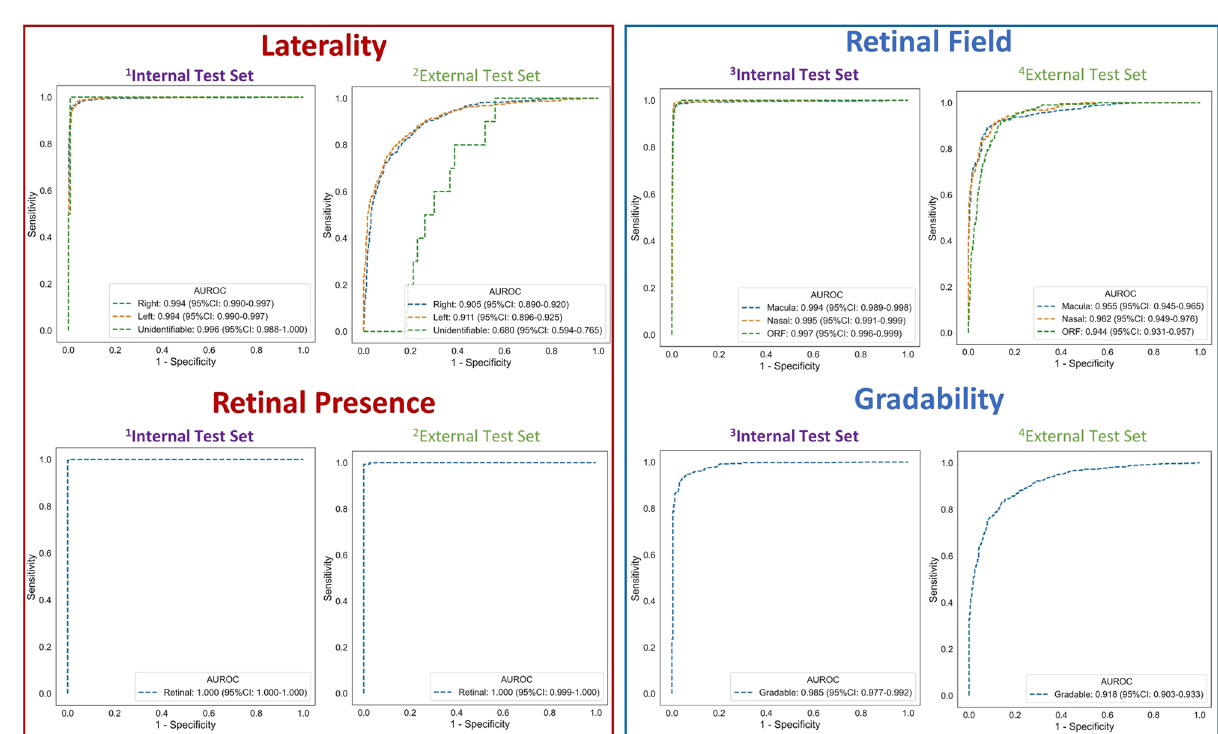
Figure 4. Multi-output model receiver operating characteristic curves. 1 Test set size = 1541 images, 2 Test set size = 1479 images, 3 Test set size = 1466 images, 4 Test set size = 1427 images. AUROC: area-under-the receiver operating characteristic curve, ORF: other retinal